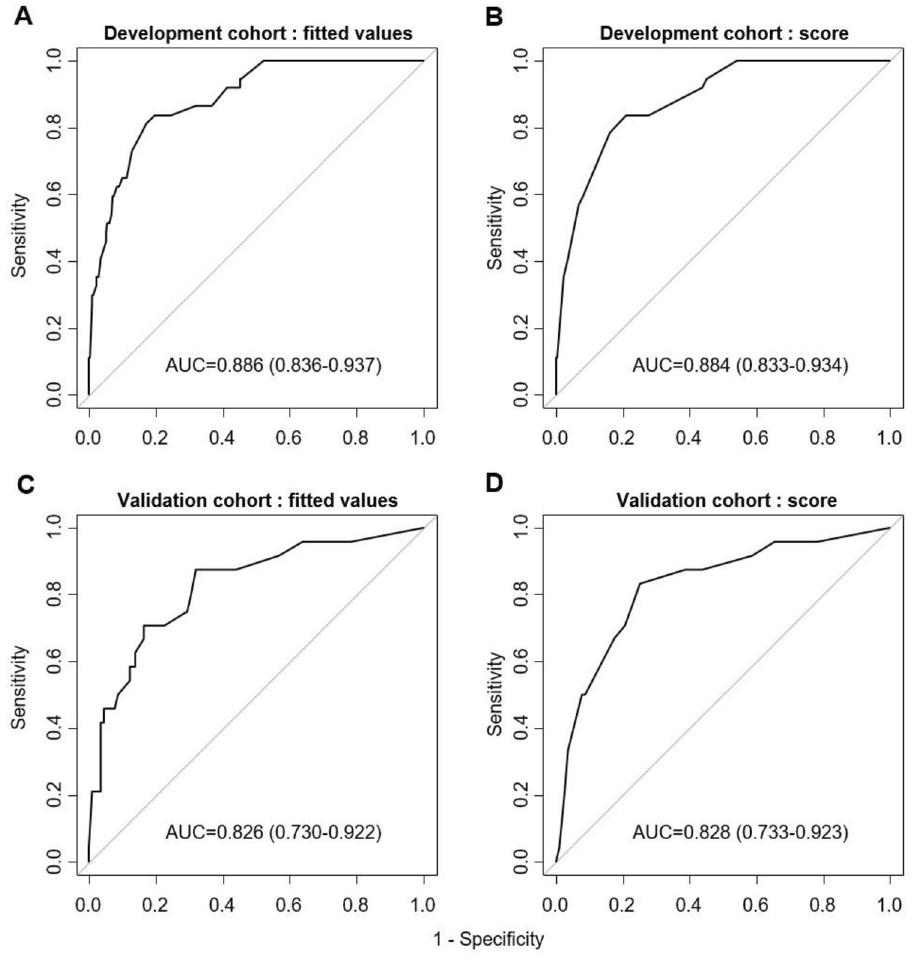
Figure 2. Discrimination ability of the severe pneumonia in prediction model in patients with Covid-19. Receiver operating characteristics (ROC) curves for predictive value in the ( A ) development cohort: fitted value, ( B ) development cohort: KDDH score, ( C ) validation cohort: fitted value, and ( D ) validation cohort: KDDH score.